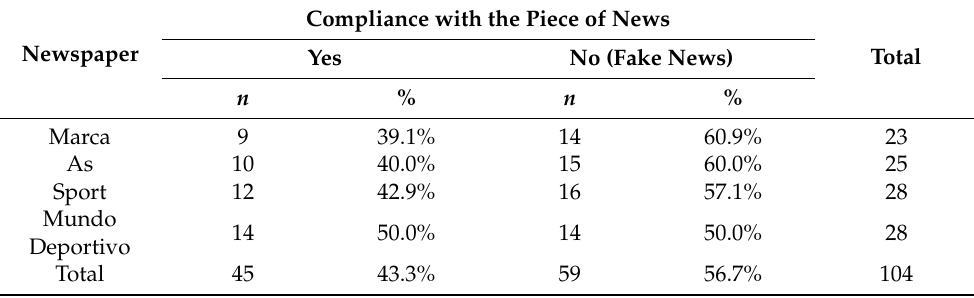
Table 4. Compliance rate depending upon newspaper. Compiled by author.